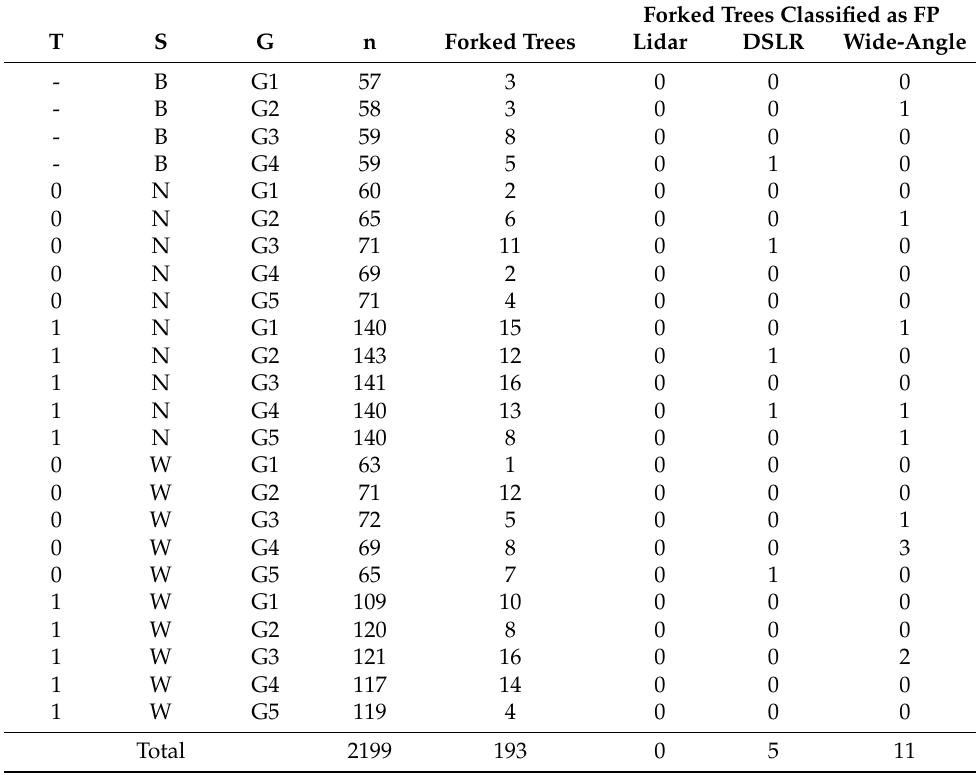
Table 4. Forked trees classified as false positive (FP) in different sensors.